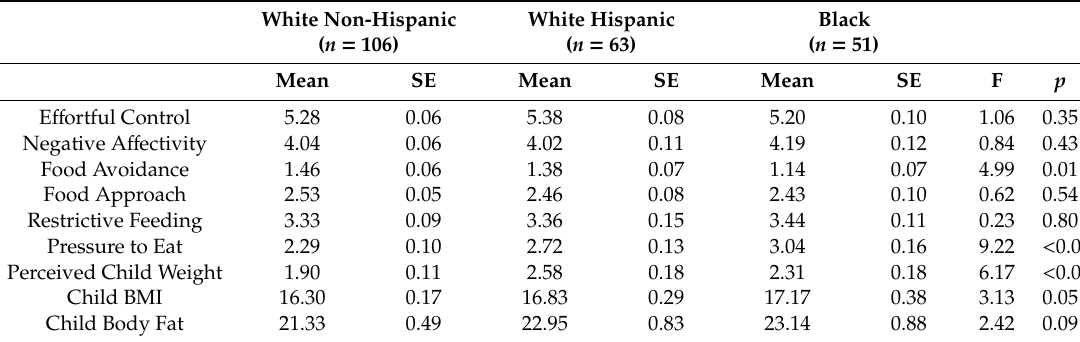
Table 4. Racial / ethnic di ff erences for all the